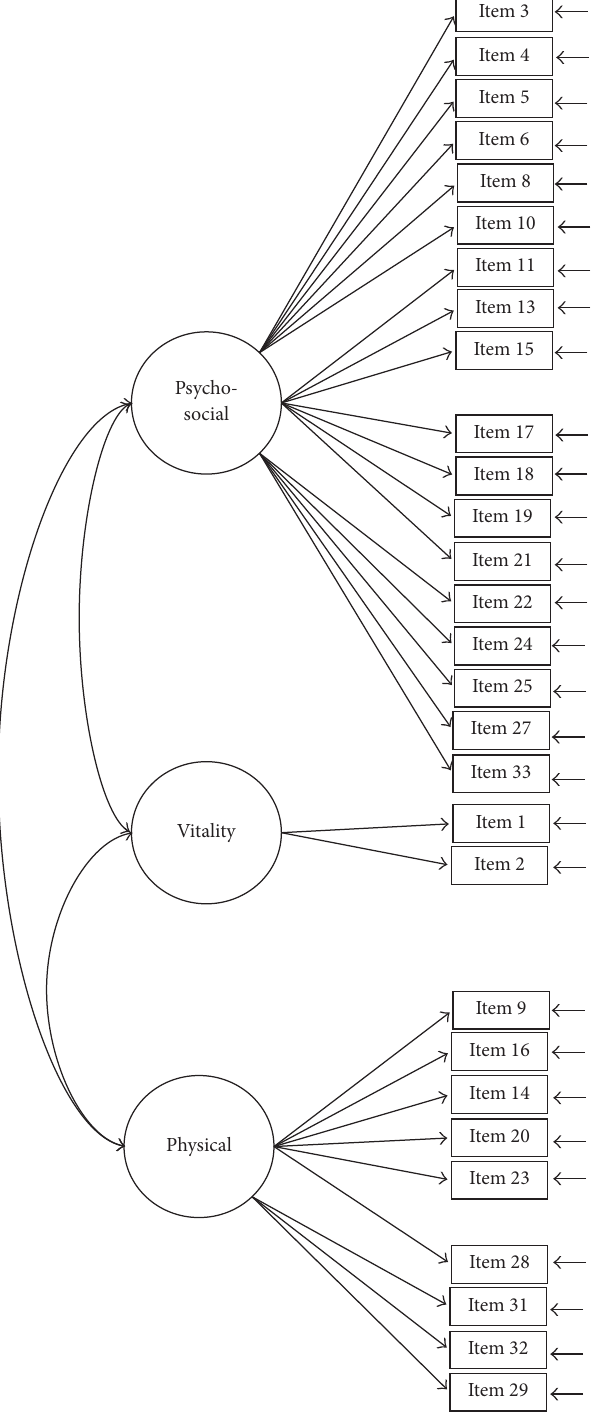
Figure 3: Model 3: the three-correlated-factor model with 29 items. Item descriptions are in Table 3.